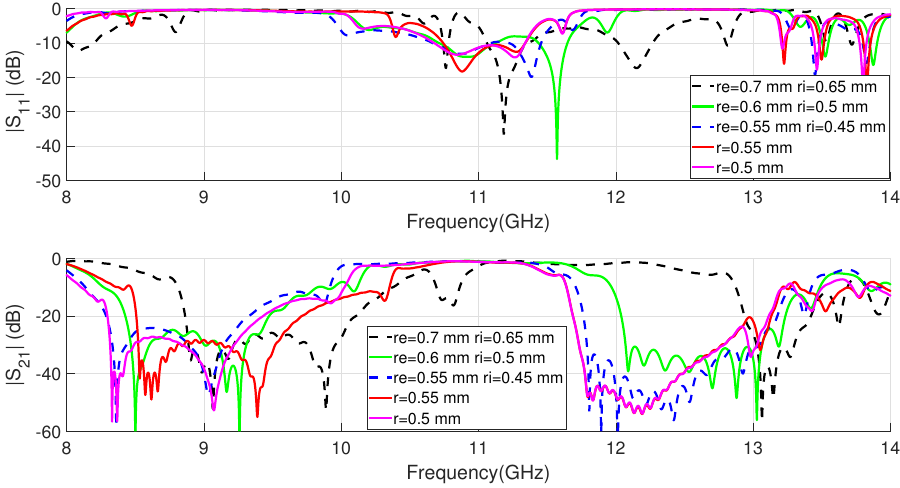
Figure 7. Simulated S parameters for the dual-band EBG filter for different short-circuit